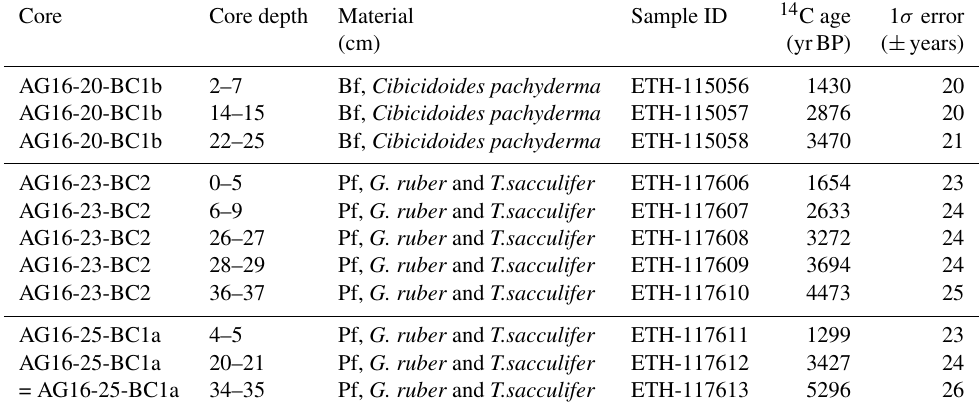
Table 3. Radiocarbon AMS14C of benthic (Bf; Cibicidoides pachyderma ) and planktonic (Pf; Globigerinoides ruber and Trilobatus sac- culifer ) foraminifera obtained from cores AG16-20-BC1b, AG16-23-BC2, and AG16-25-BC1a. The three cores were dated independently: one was dated with benthic foraminifera and two were dated with planktonic foraminifera in the absence of sufficient benthic specimens for dating in all the three cores. The ages of benthic and planktonic foraminifera that were selected from the top layers of cores AG16-20- BC1b (2–7cm; benthic foraminifera) and AG16-23-BC2 (0–5cm; planktonic foraminifera) appear to be close (ca. 200 14 C years difference). The benthic age is even younger, pointing to variability in the reservoir age of the mixed layer. The location of the sampling sites (close to the shore) might be the reason for such close reservoir ages between benthic and planktonic foraminifera. More details are reported in Supplement